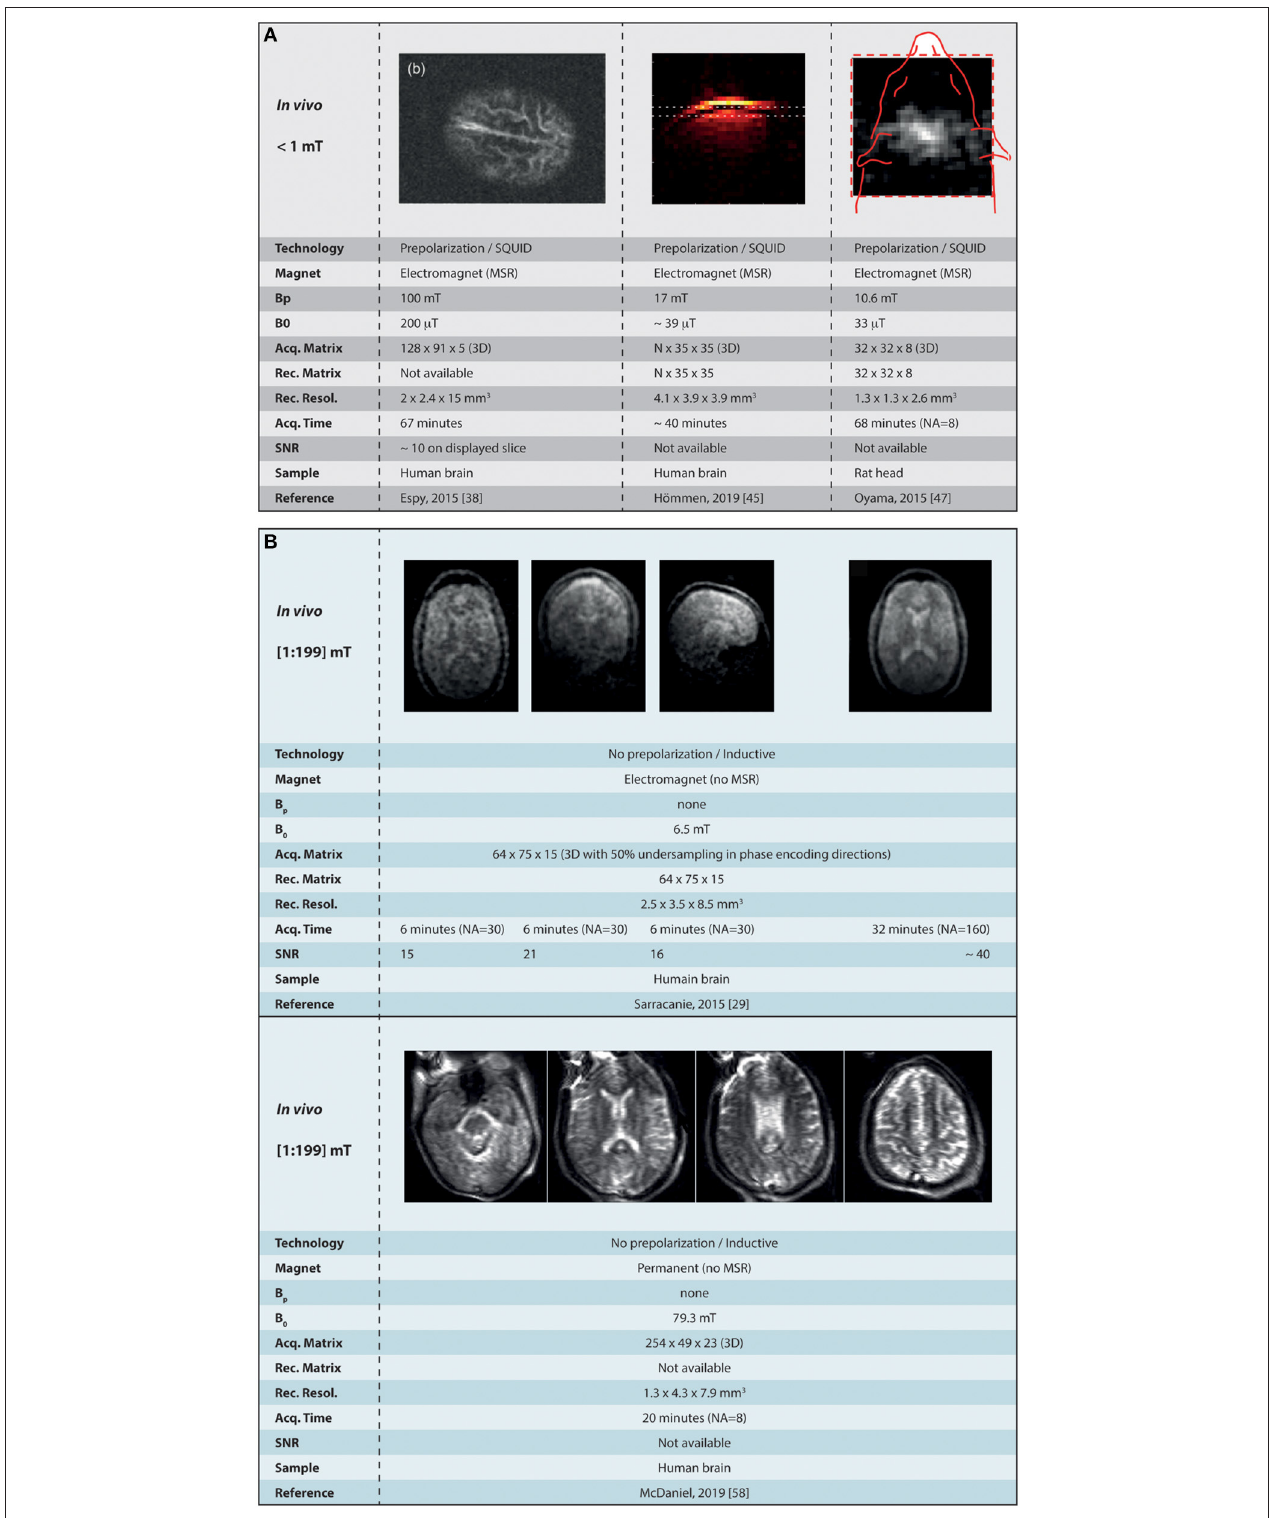
FIGURE 4 | Summary of the current landscape of low-field MR imaging in vivo . (A) Shows the major achievements obtained at ultra-low field (micro tesla range) in combination with SQUID detectors, and (B) the images obtained in the mT range (from 1 to 199 mT). MSR, magnetically shielded room; CMSB, compact magnetically shielded box; B p , polarization field; NA, number of signal averaging. Images reused, with permission, from Espy et al. [38], Hömmen et al. [45], Oyama et al. [47], McDaniel et al. [58]. Images reused from Sarracanie et al. [29], held under Creative Common License CC-BY 4.0.